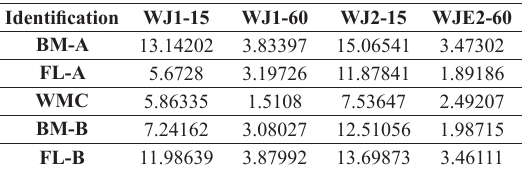
Table 4. DOS/DPPF ratio for all conditions investigated (except as-welded